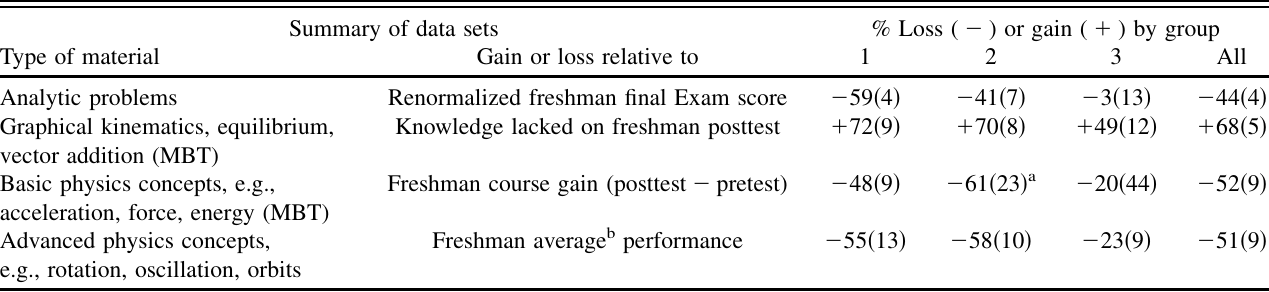
TABLE X. Summary of percentage loss ( (cid:4) ) or gain ( þ ) for each major group in each data set studied. Summary of data